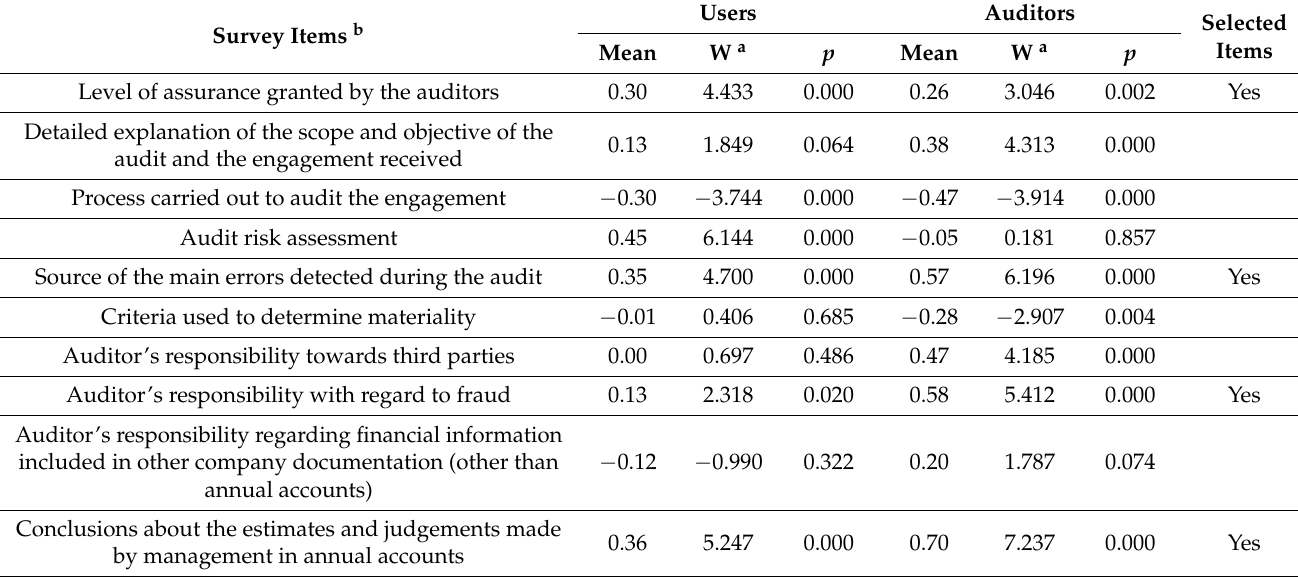
Table 6. Preferences regarding the content of audit report to enhance its